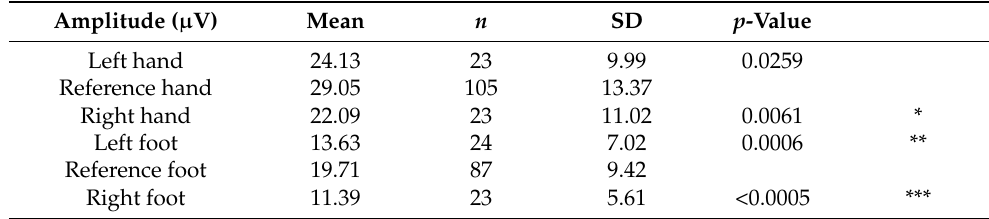
Table 2. LEP amplitudes in µ V for evoked potentials on left and right dorsum of the hand or foot. Reference material derived from in-house, healthy subject normative data. *, **, and *** indicate statistically significant differences to reference material with p -values corresponding to Bonferroni corrected 0.05, 0.01, and 0.001,